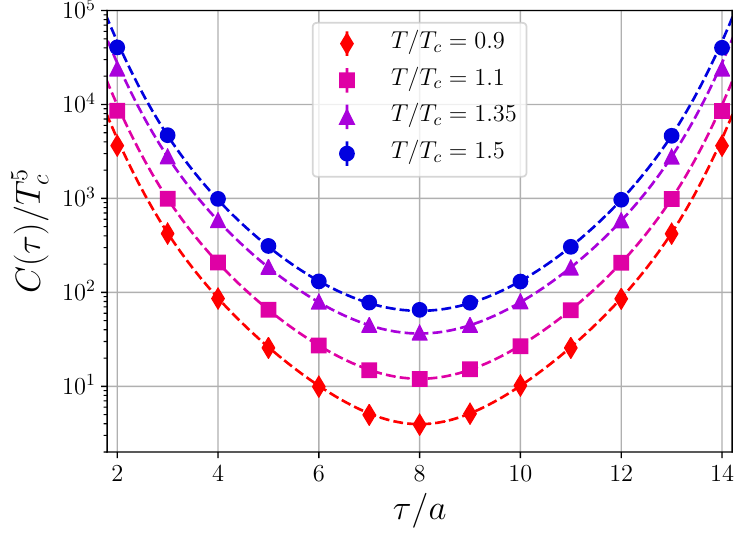
Figure 1 . The correlation functions C ( x 0 ) for the temperatures T=T c = 0 : 9 ; 1 : 1 ; 1 : 35 ; 1 : 5. The dashed curves are the correlation functions obtained with the spectral function in form (3.1) with the parameters obtained from the (cid:12)tting procedure (see table